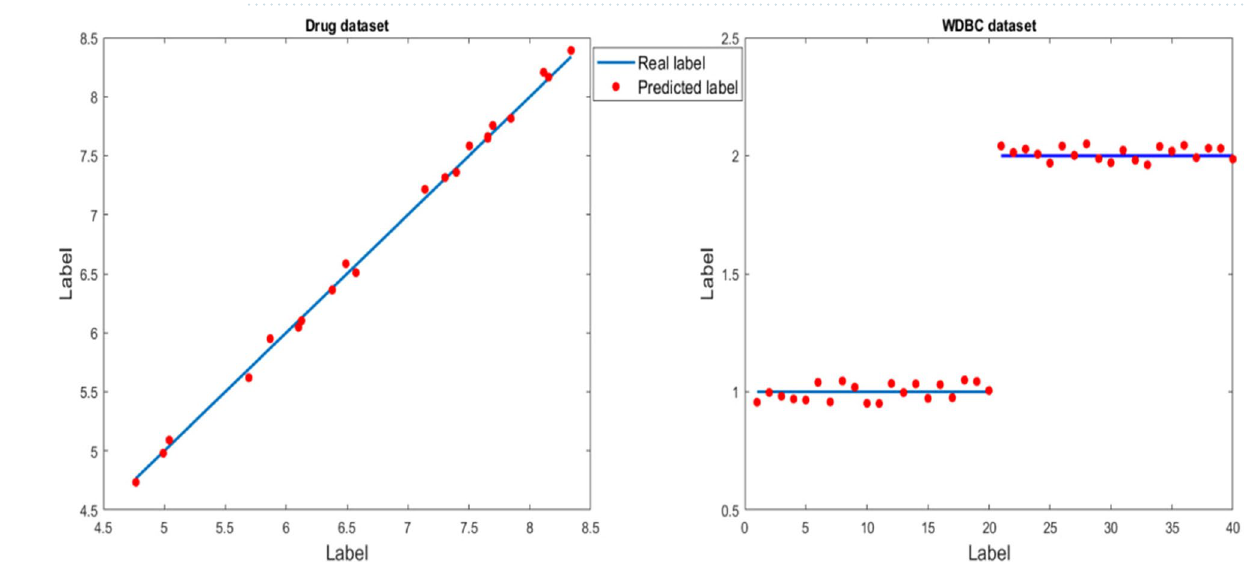
Figure 18. Scatter plot of the proposed method on the Drug and WDBC datasets. Blue and red points indicate real and predicted values, respectively. The value of RMSE for the drug and WDBC datasets are 0.14 and 0.01,